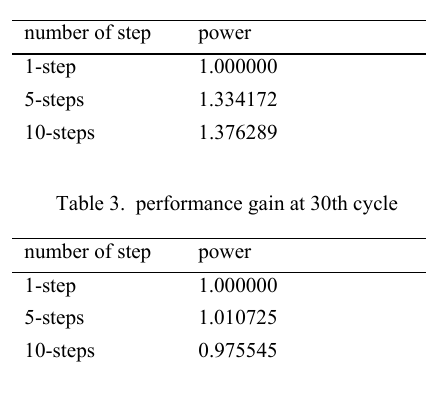
Table 2. performance gain at 4th cycle